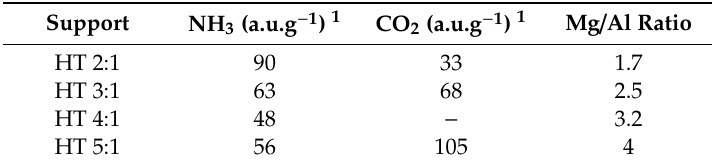
Table 3. Desorbed NH 3 and CO 2 amounts in TPD for